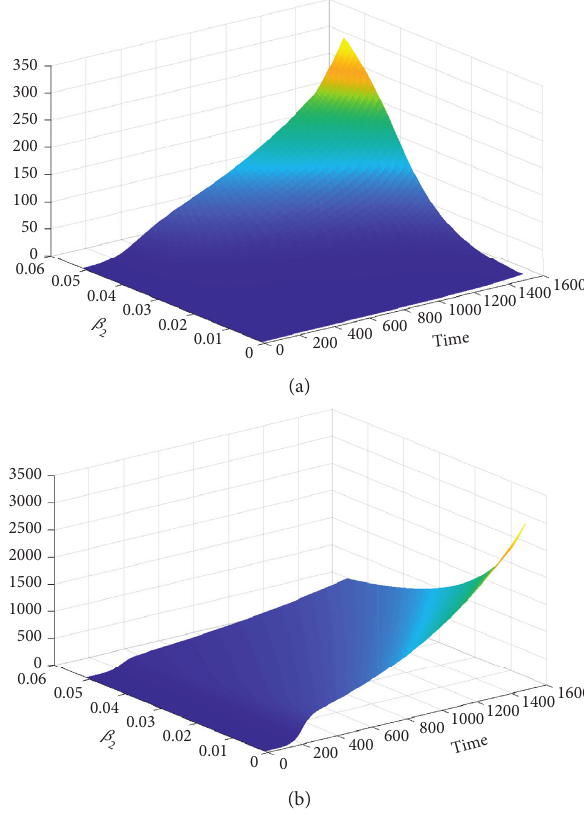
Figure 9: Amount of the information as a function of time and β parameter. (a) Simulation with controls u and v . (b) Simulation without